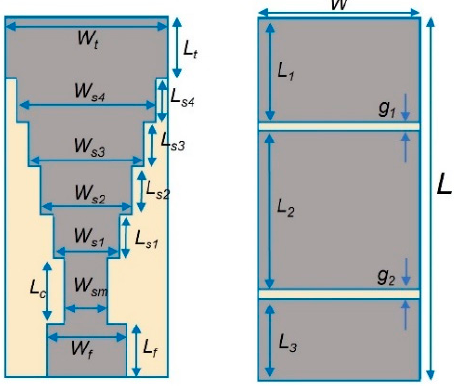
Figure 3. The geometry of the stepped monopole antenna.